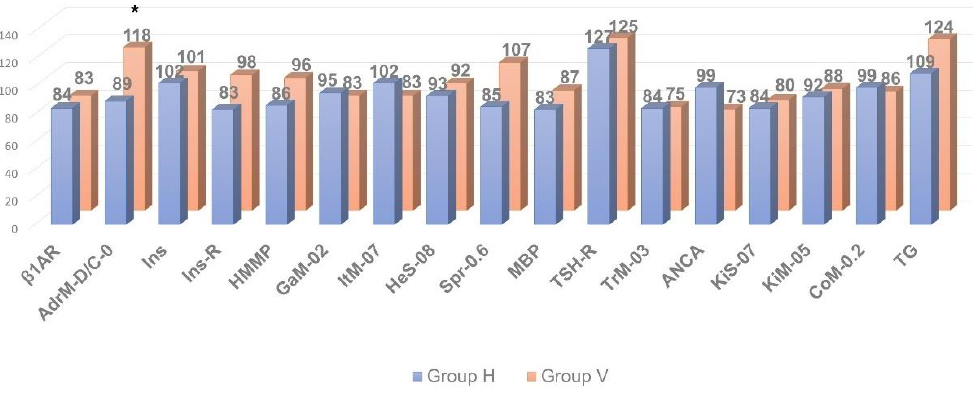
Figure 4. Comparative analysis of anti-visceral autoantibody concentration in individuals with clinically significant chronic fatigue of post-viral etiology (group V, n = 13) and healthy individuals (group H, n = 12). * p ≤ 0.05, group V > group H.